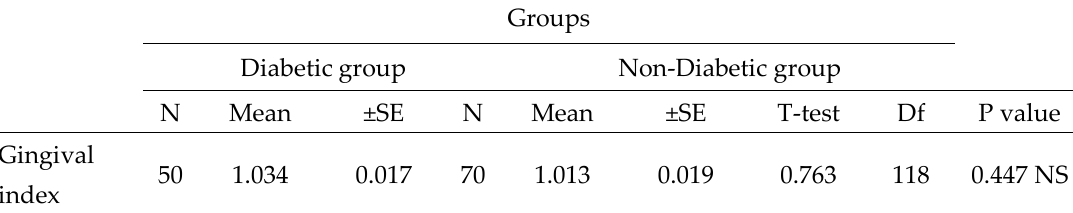
Table (6): Mean value of gingival index among diabetic and non-diabetic groups.